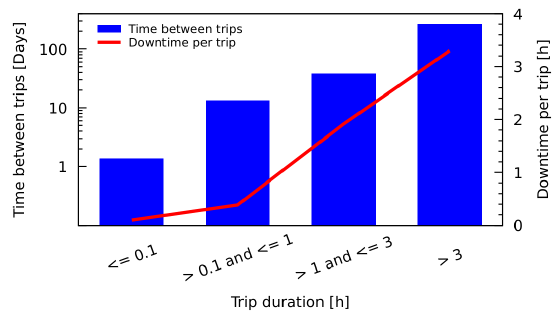
FIG. 7. Average time between SRF trips (left-hand side vertical axis) and average downtime per trip (right-hand side vertical scale) in the indicated trip duration categories in FY20.